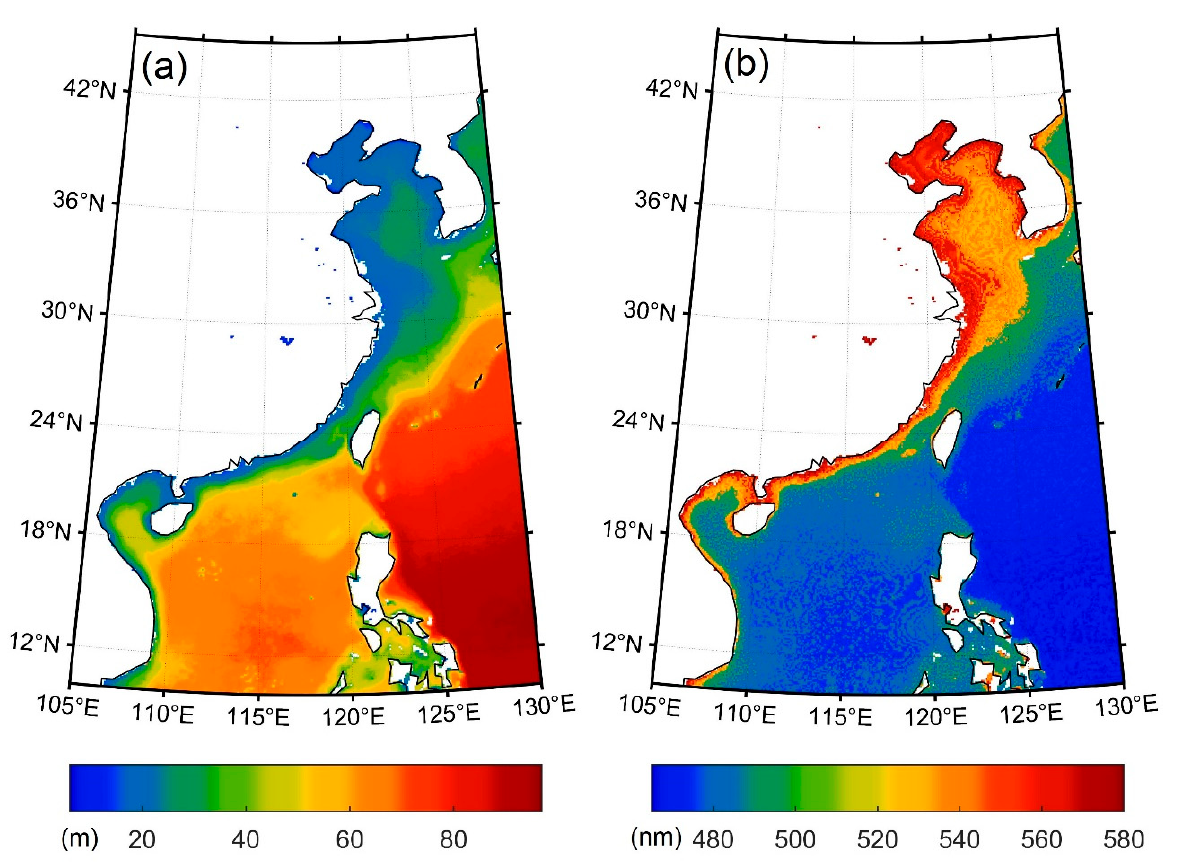
Figure 11. The lidar maximum detectable depths ( a ) and corresponding optimal laser wavelengths in China’s coastal area ( b ).